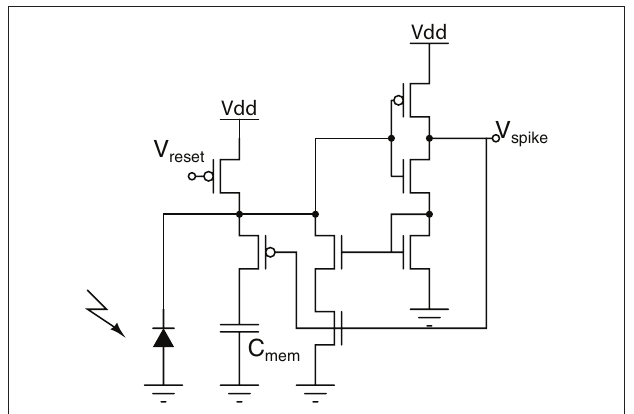
FIgure 10 | The octopus retina neuron. The input current is generated by a photodetector, while the spike generator uses positive current feedback to accelerate input and output transitions to minimize short-circuit currents during spike production. The membrane capacitance ( C from the input of the spike generator to further accelerate transition and to reduce power during